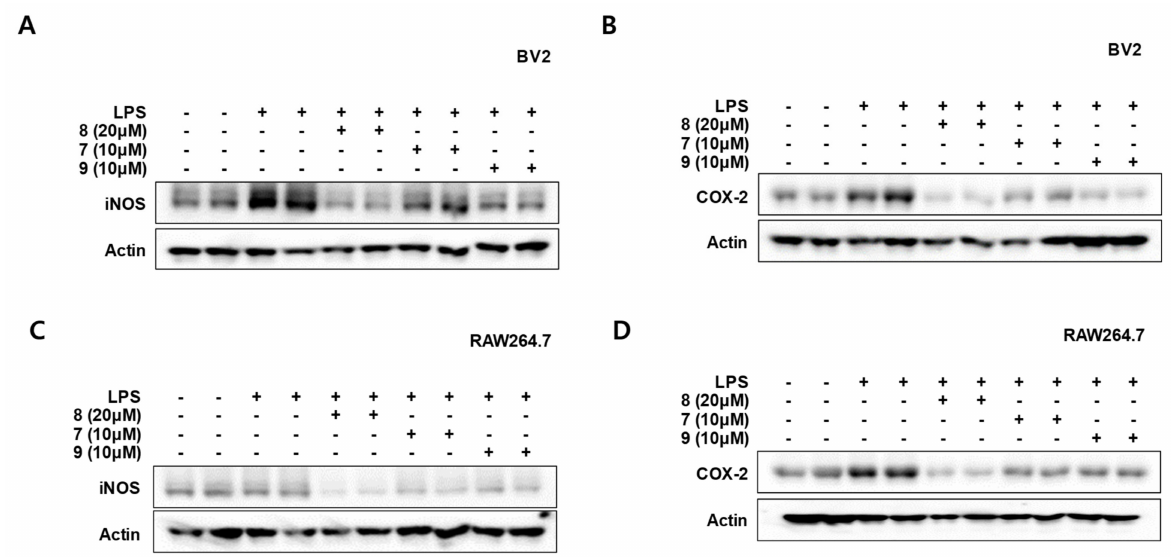
Figure 6. Protein expression levels of inducible nitric oxide synthase (iNOS) and cyclooxygenase-2 (COX-2) by compounds 7 – 9 in LPS-stimulated BV2 ( A , B ) and RAW264.7 ( C , D ) cells. Cells were pretreated for 3 h with indicated concentrations of compounds 7 – 9 and stimulated for 24 h with LPS (1 µ g/mL). Western blot analysis was performed as described in Materials and Methods. Representative blots from three independent experiments are